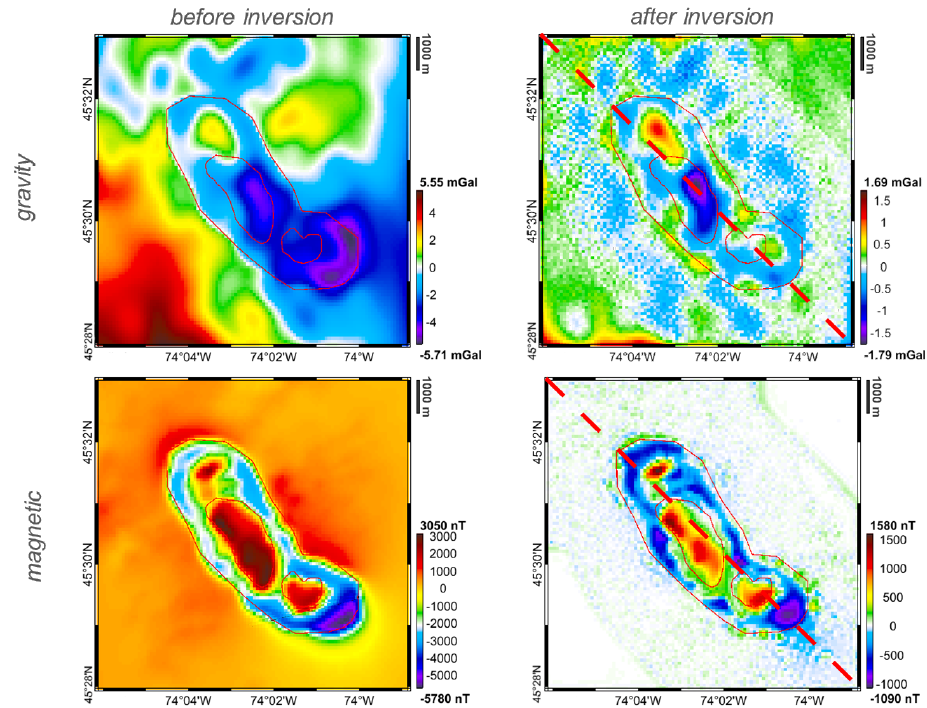
Figure 5. Residuals before ( left ) and after ( right ) applying the joint inversion for the gravity ( up ) and magnetic ( down ) fields. Red lines represents the boundaries of main units of the Oka complex. Red dashed line is the profile shown in Figure